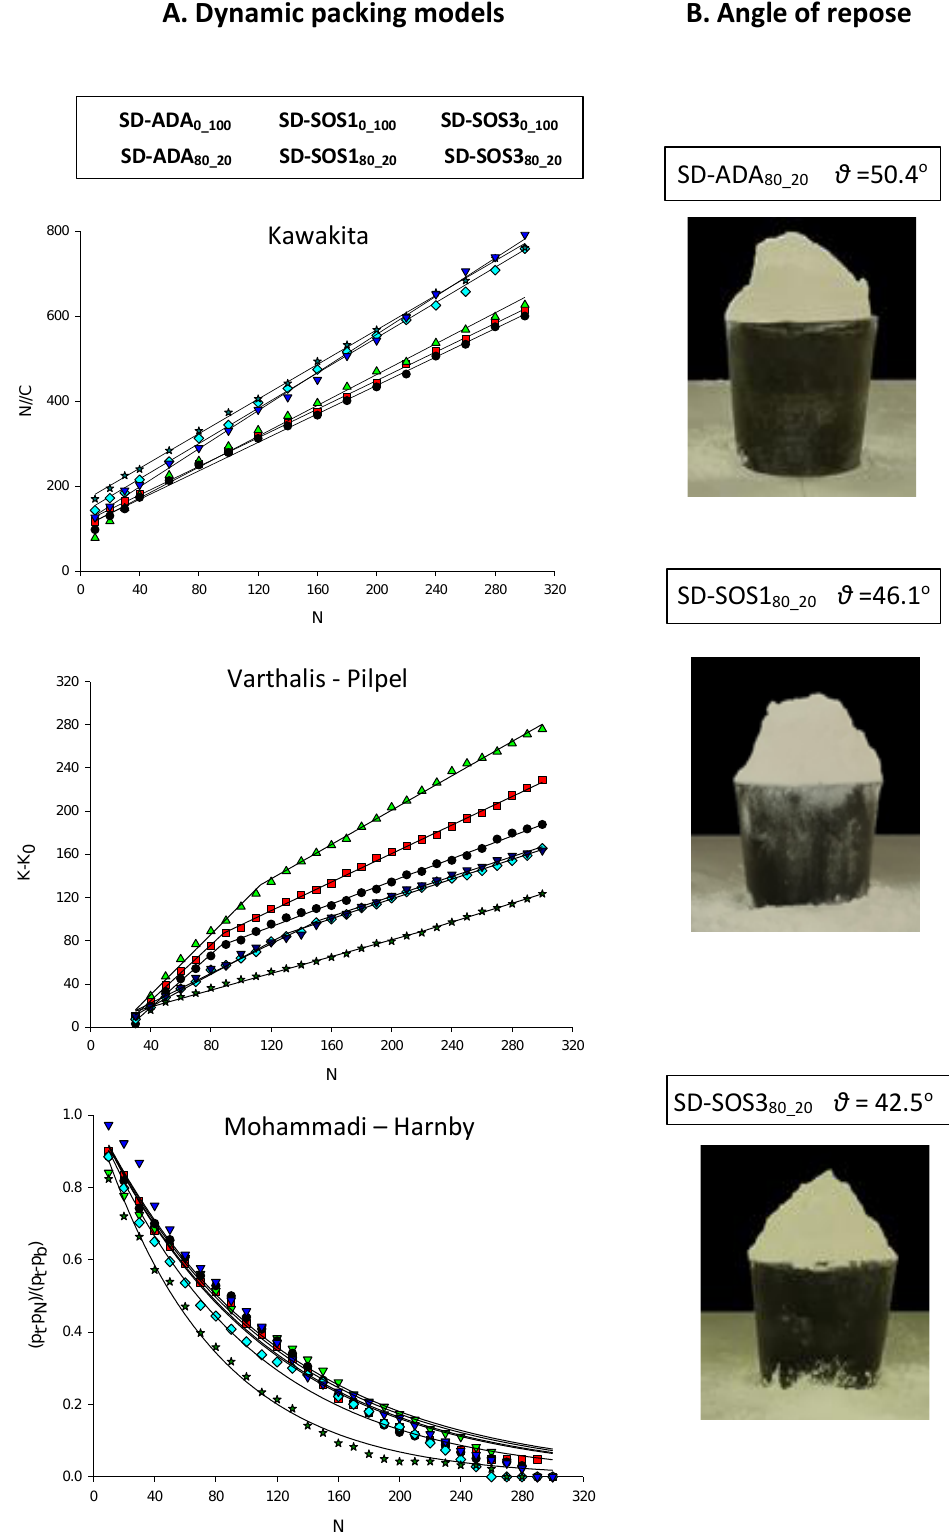
Figure 7. ( A ) Plots of densification functions vs. tapping number (N) according to Kawakita, Varthalis–Pilpel, and Mohammadi–Harnby equations. ( B ) Images of conical heaps of EO spray-dried products encapsulated in polymer / polysaccharides 80 / 20 wall (products with a polysaccharides wall only could not form a cone).